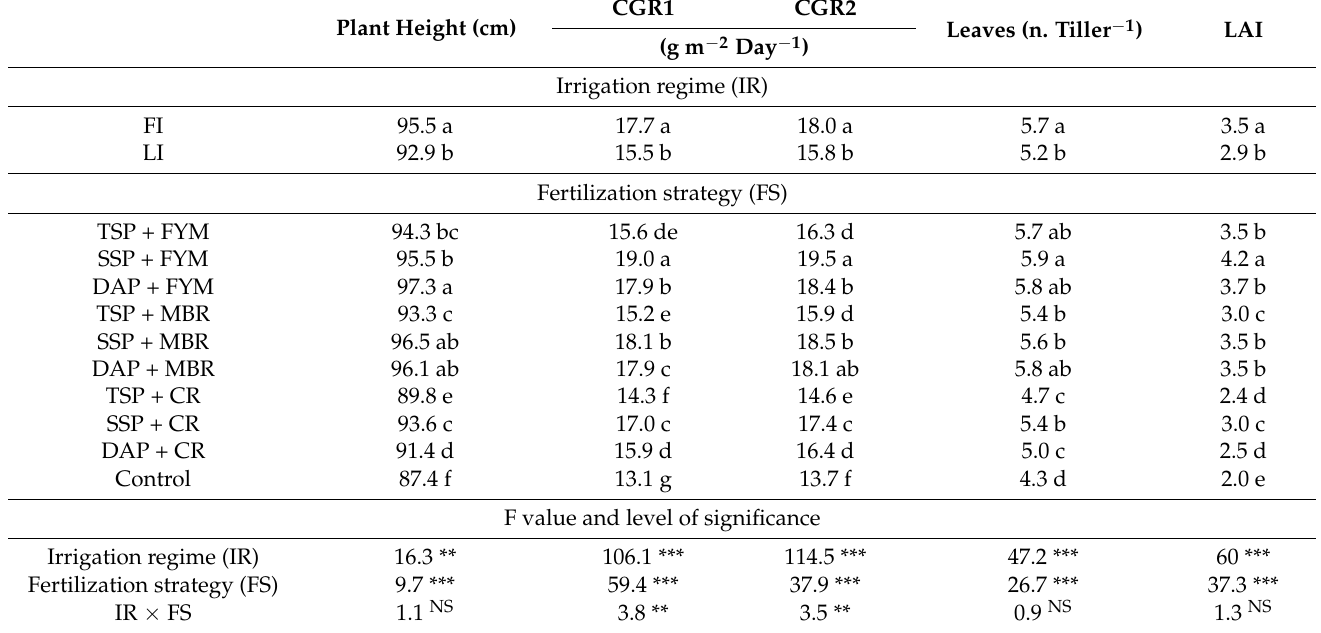
Table 3. The effect of fertilization sources and irrigation regimes on plant height, crop growth rate (CGR), number of leaves, and leave area index (LAI) of wheat. CGR1 CGR2 Plant Height (cm) Leaves (n. Tiller − 1 ) LAI (g m − 2 Day − 1 ) Irrigation regime